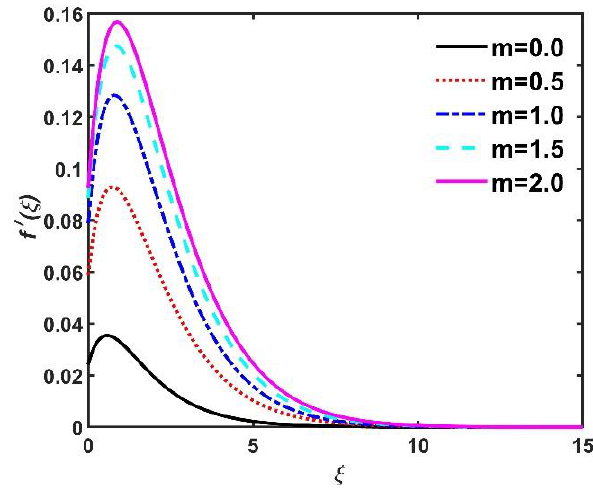
Figure 14. Impact of 𝑚 on 𝑓′(𝜉) .